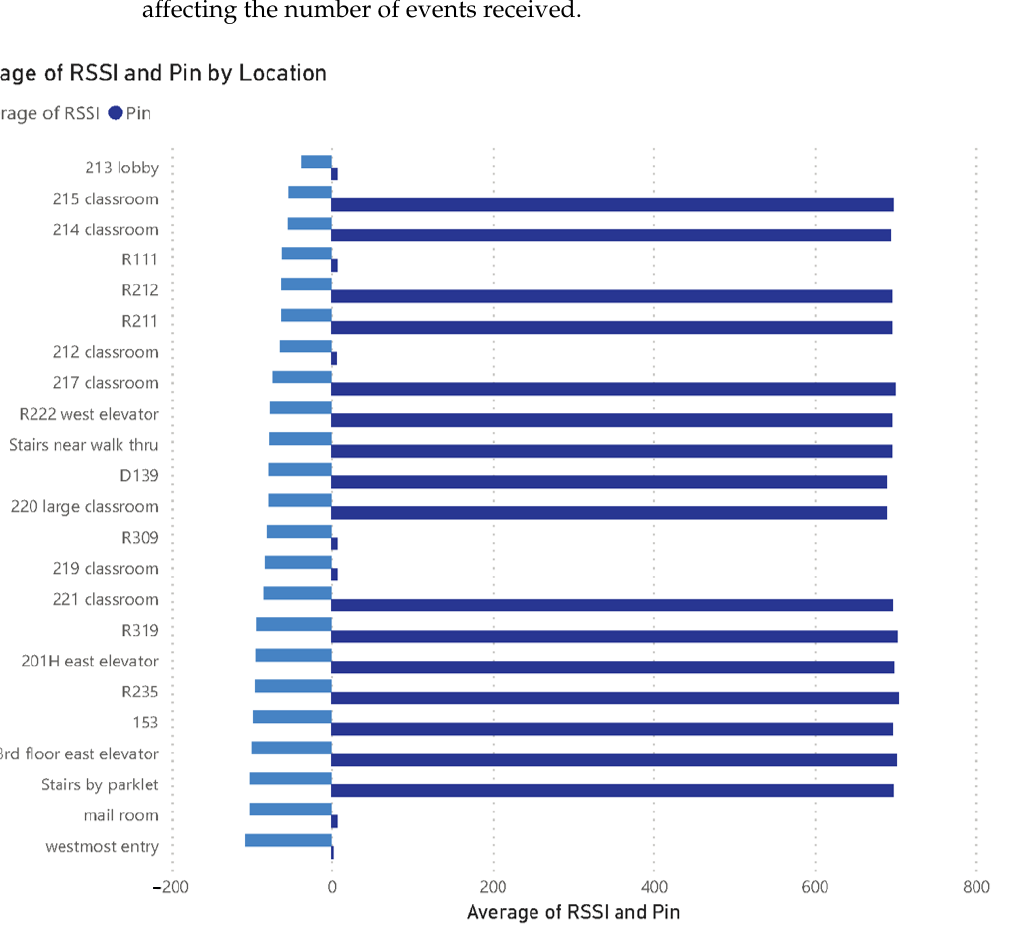
Figure 13. Comparing received messages with signal quality from the real-world field test. The sensors were ranked by their signal quality (high to low).